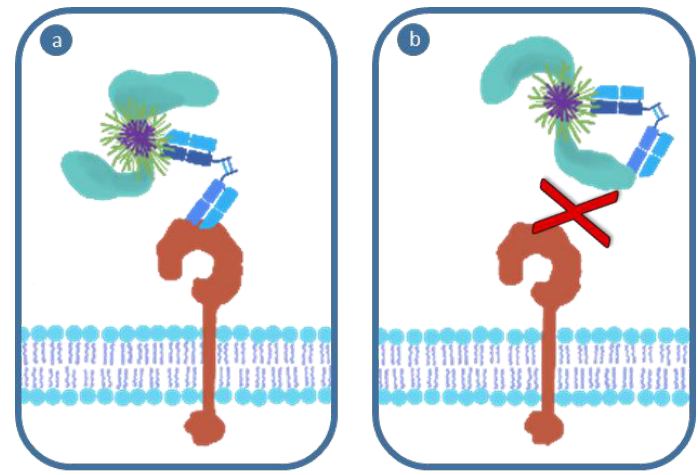
Figure 4. Schematic demonstrating the impact of opsonization on targeting efficiency: ( a ) Desired targeting, wherein binding is maintained; and ( b ) binding hindered by interactions with non-specifically bound protein.